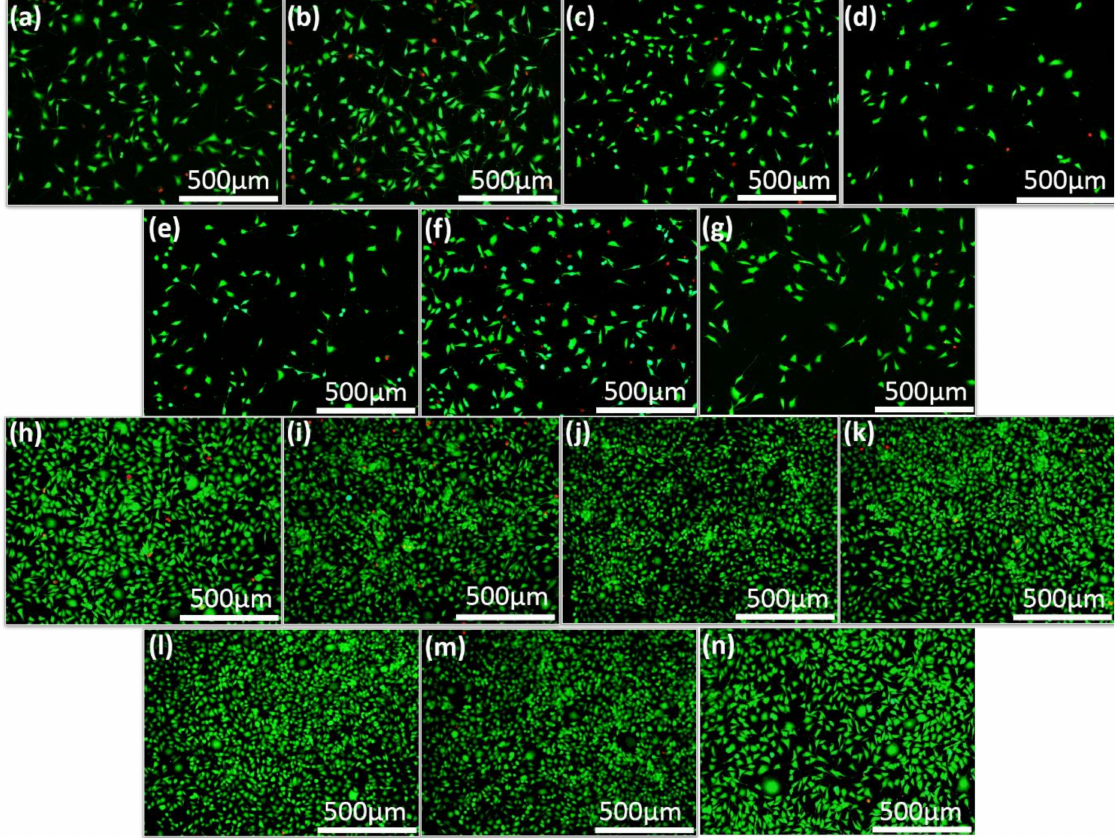
Figure 5. Live/Dead staining of MG-63 cells after cultured in HA samples and DMEM for 1 day ( a – g ) and 3 days ( h – n ). ( a – g ), ( h – n ) are S1–S6 samples and ( g ), ( n ) DMEM which acted as the control